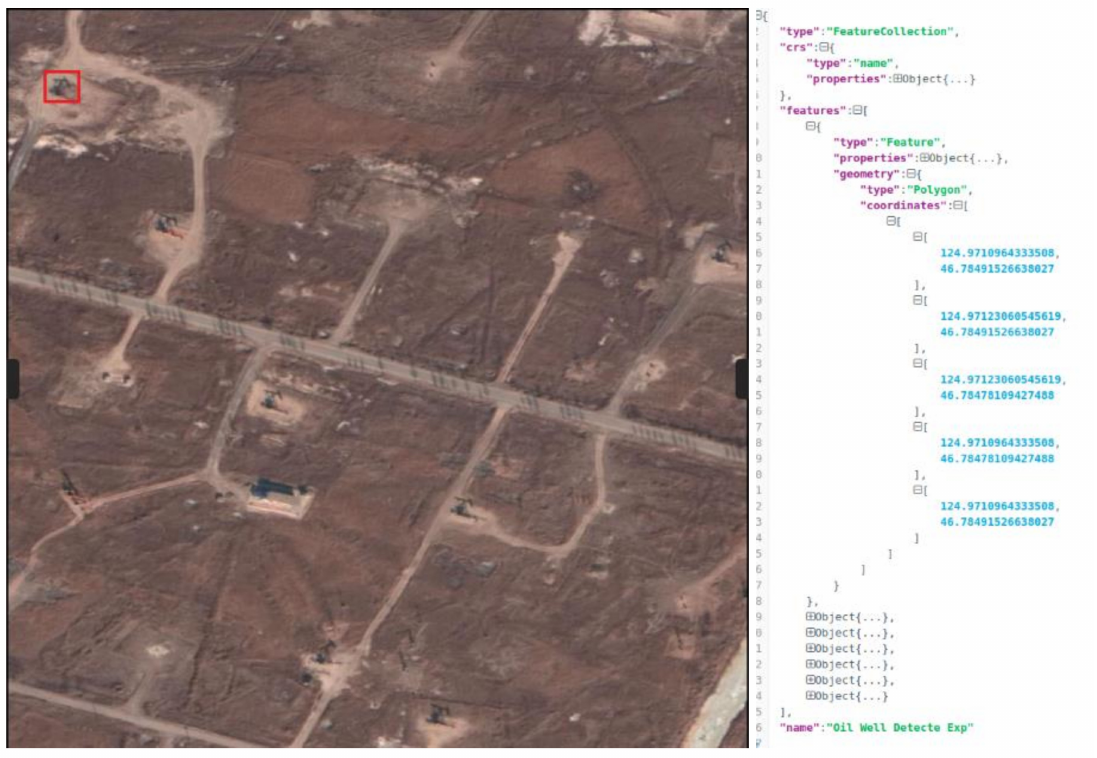
Figure 7. Oil wells annotation details.